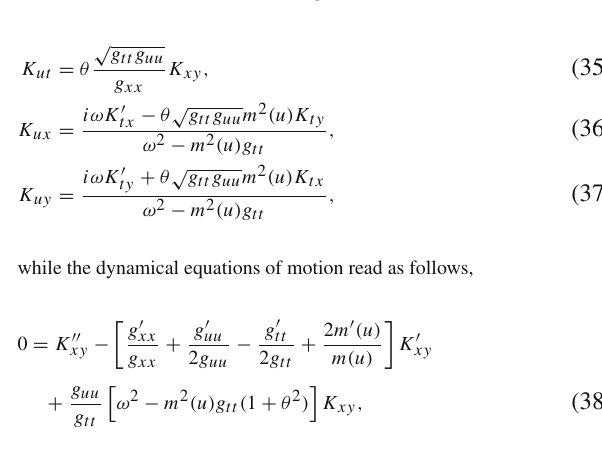
and K (cid:5) , and K uy as function of K tx and K (cid:5) tx the Fourier mode K μν ( u , t , ω) ≡ e − i ω t K μν ( u , ω) into